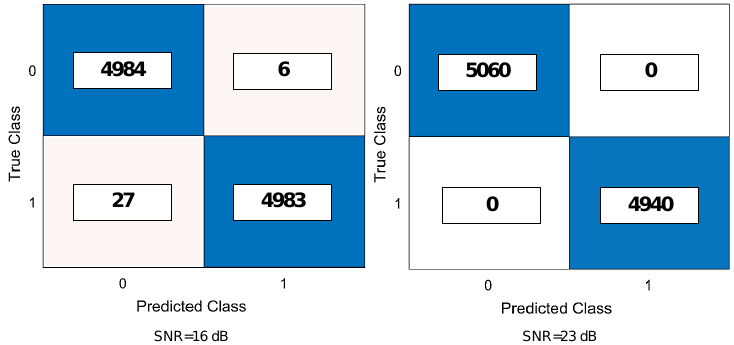
Figure 6. Confusion chart of the LSTM-based classifier under AWGN channel for β = 50,